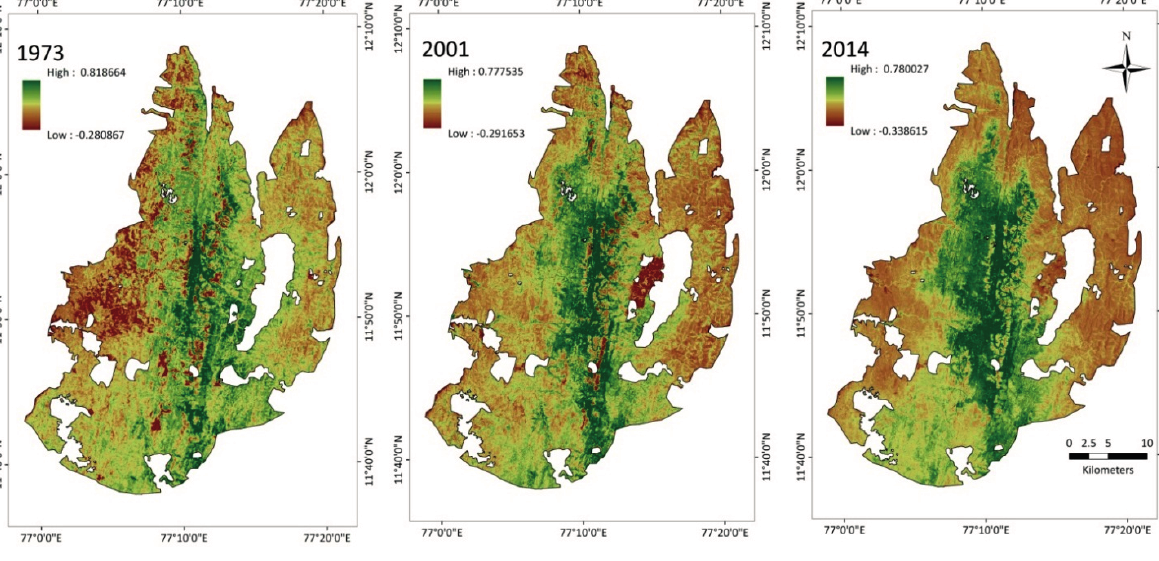
Figure 5. NDVI maps of the Biligiri Rangaswamy Temple Tiger Reserve (BRT) landscape and the surrounding Edeyarahalli, Punajanur and Mudalli corridors in 1973, 2001 and